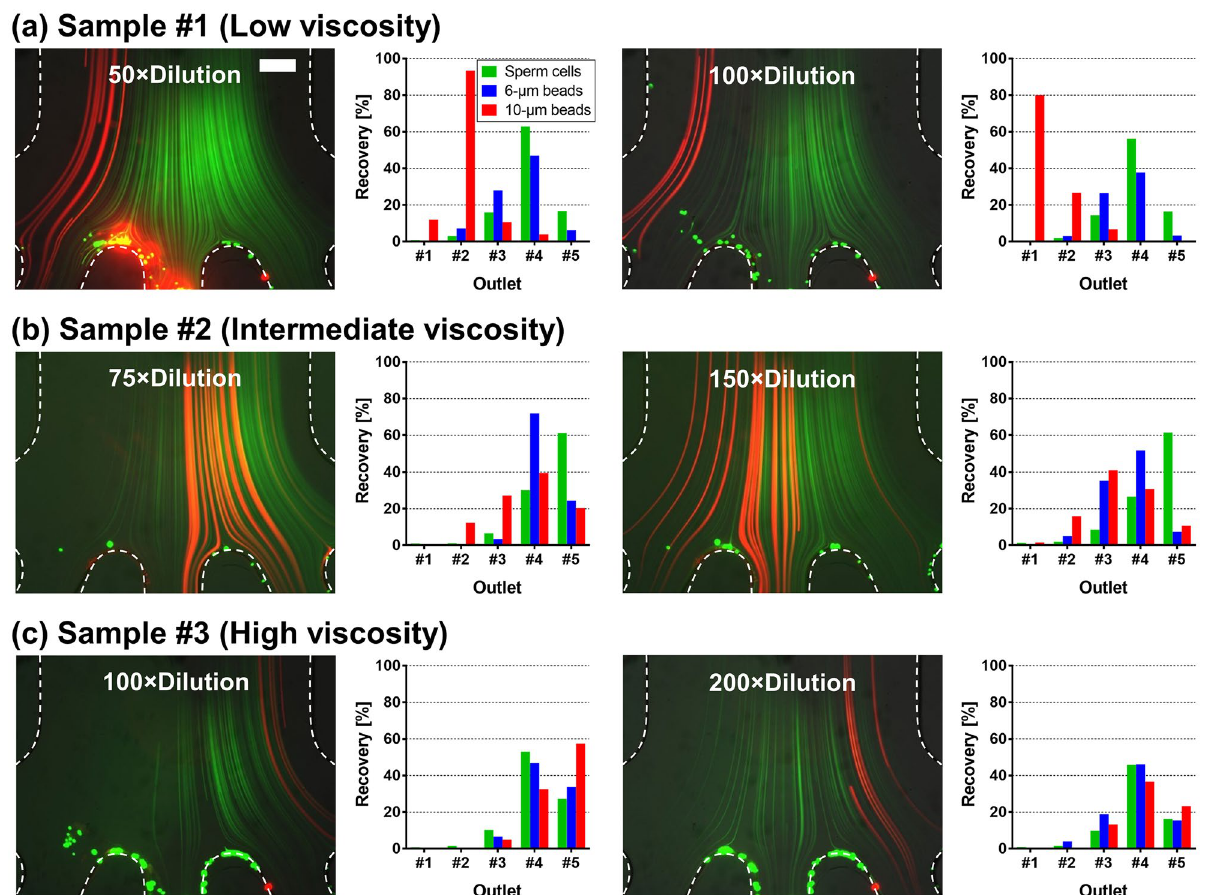
Figure 2. Sample-dependent device performance. ( a – c ) Trajectories of 6-μm (green) and 10-μm (red) beads spiked in semen samples having different viscosity conditions (low-, intermediate-, and high-viscosity condition, respectively) with the low and high dilution conditions under the optimal flow rate condition, 2.0 mL/min (scale bar: 200 μm), and graphs showing corresponding recoveries of sperm cells and 6- and 10-μm beads from each outlet; 10-μm beads were used to mimic leukocytes, and 6-μm beads were used to indirectly observe the movement of the sperm cells without staining the sperm cells themselves; viscosity of semen was determined based on WHO guidelines by the thread length when dripping the semen sample (≤ 2 cm for low viscosity, 2–4 cm for intermediate viscosity, and > 4 cm for high viscosity) 41 ; mHTF containing 5-mg/mL BSA was used as a buffer solution for sample